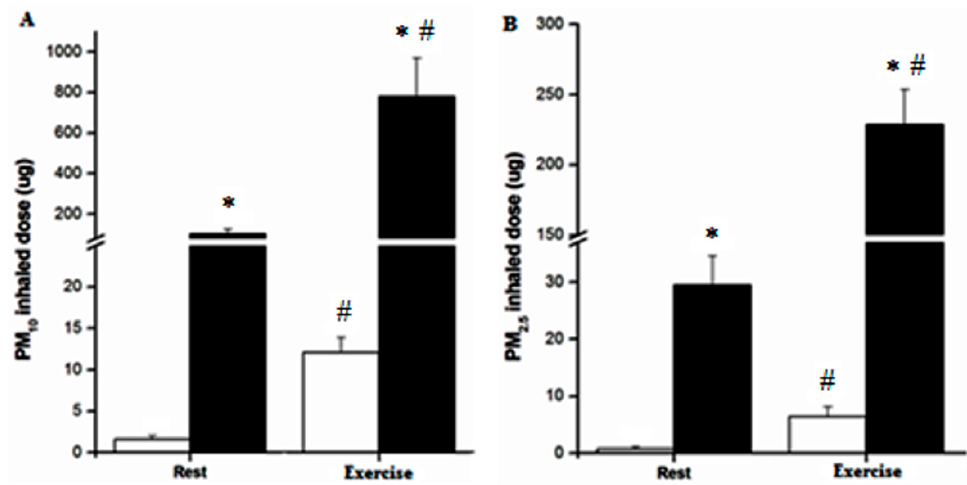
Figure 3. Inhaled PM 10 (panel ( A )) and PM 2.5 (panel ( B )) during 30 min at rest and exercise by city category: cleanest (white bars) and dirtiest (black bars). * Significantly different from rest at the same city category (cleanest or dirtiest); # Significantly different from the same situation (rest or exercise) at different city category ( p < 0.05).